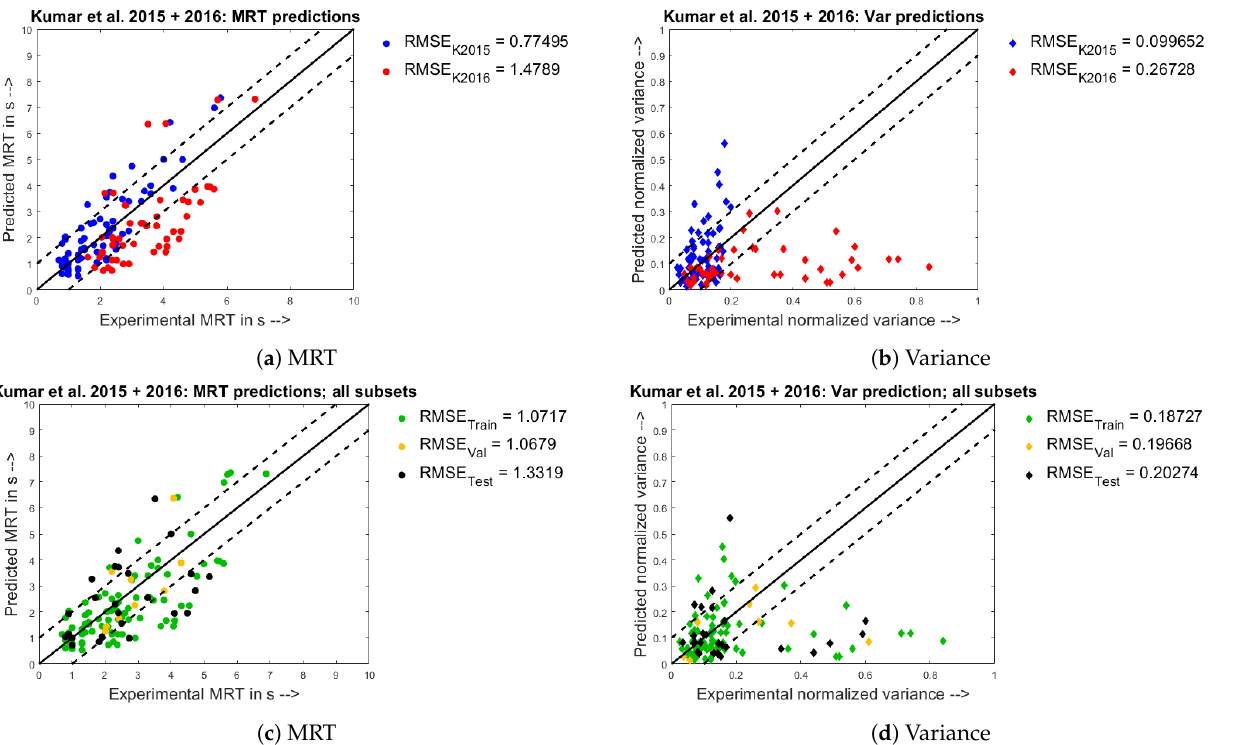
Figure 10. Experimental observations (X) vs. predicted model responses (Y) when trained on the combined Kumar et al. 2015 + 2016 [21,26] set.